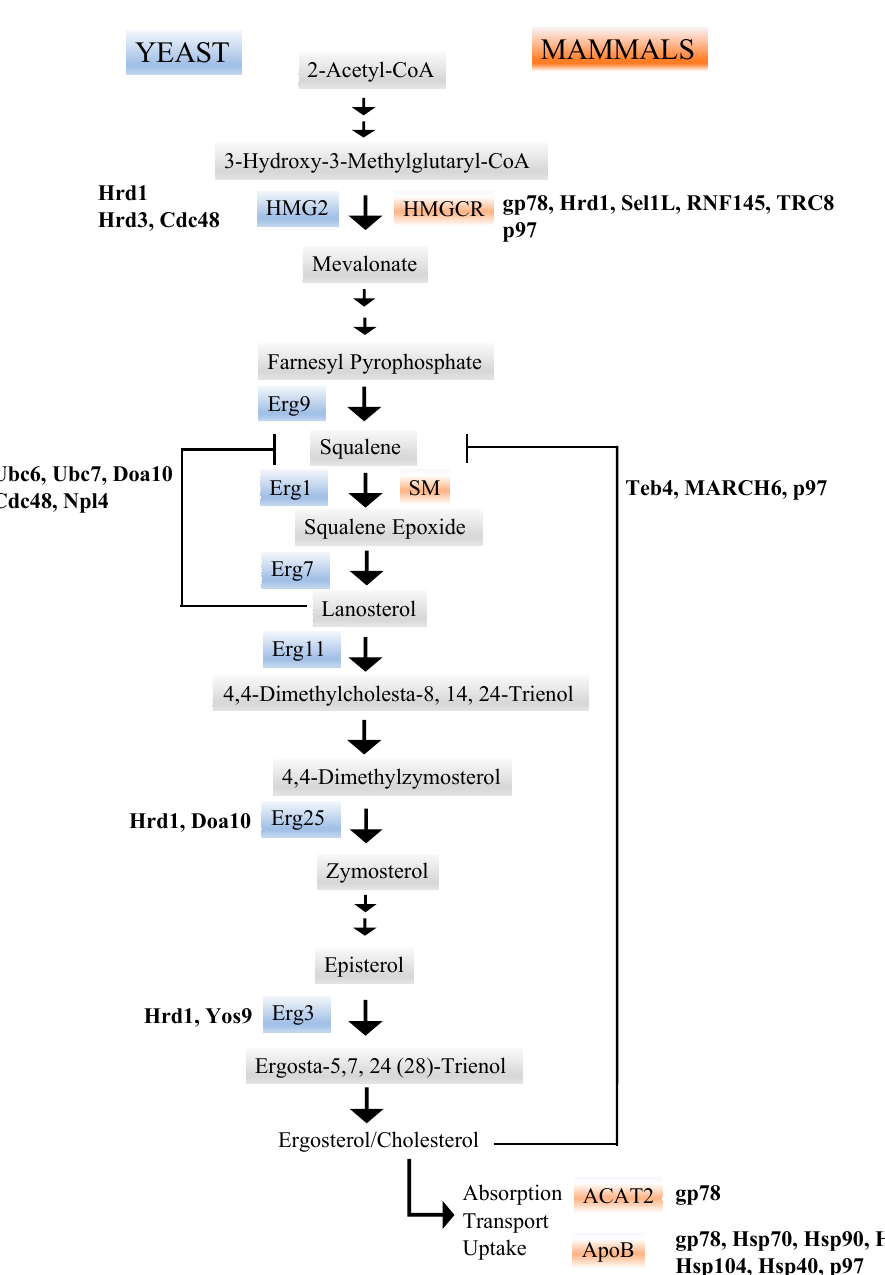
Figure 2. The biosynthetic pathway that leads to the generation of ergosterol (in yeast and fungi) and cholesterol (in higher organisms). The ergosterol and cholesterol biosynthetic pathways are catalyzed by a cascade of enzymes, including those shown as well as others that were not highlighted in the text. Select examples of feedback loops are also shown. Key enzymes regulated by ERAD in yeast (ergosterol biosynthetic pathway, in blue) and mammals (cholesterol biosynthetic pathway, in orange) are also noted. Two factors (ApoB and ACAT2) that act after cholesterol synthesis in mammals are also highlighted. Where studied, select examples of proteins that facilitate substrate degradation by the ERAD pathway and that act on specific enzymes in these pathways are displayed in bold.